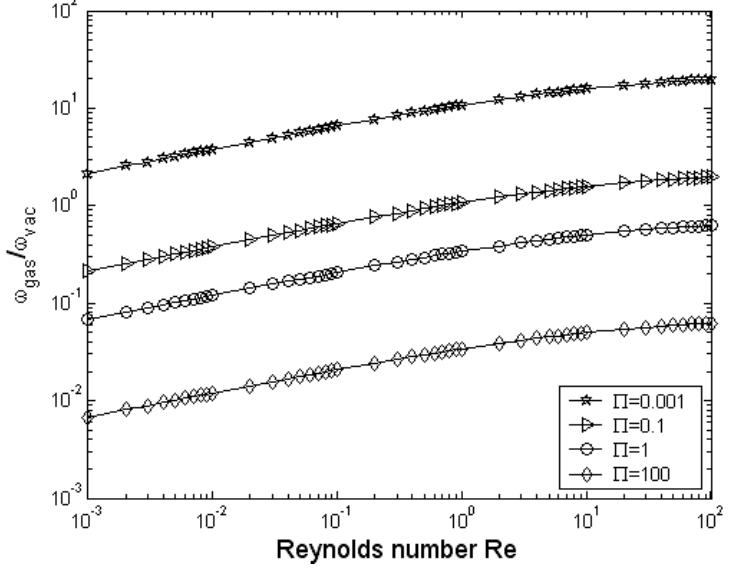
Fig. 4. Relationship between the vacuum resonant frequency ω vac and the resonant frequency in gas ω gas ( ω gas / ω vac ) as a function of the Reynolds number R e at different natural scaling parameter Π . the increase of Reynolds number R and ω decreases with the increase of the scaling parameter Π . We e gas /ω vac can obtain from Eq. (4) that the quality factor Q as a function of both natural scaling parameters, R gas illustrated in Fig. 5. It is indicated that the quality factor Q increases with the increase of the Reynolds number gas R e and the decrease of the natural scaling parameter Π . Meanwhile, when the natural scaling parameter Π tends to be a larger value (in the case of Π = 10 ), the quality factor Q has small change. As displayed in Fig. 5, when Π gas changes from 10 to 100, the quality factor Q has very small gas